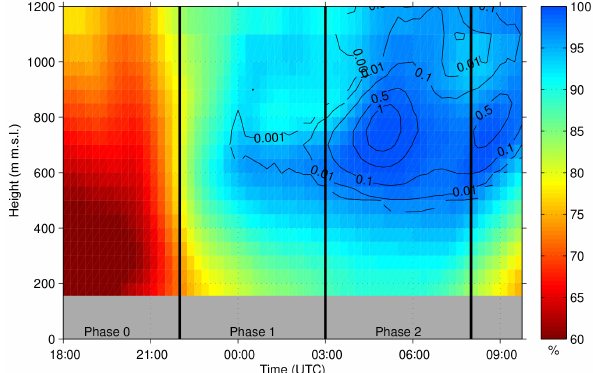
Figure 4. Temporal evolution of relative humidity (colour-coded) and liquid water content in gkg − 1 (black contours) averaged for SAVE. The grey shaded area marks the mean terrain